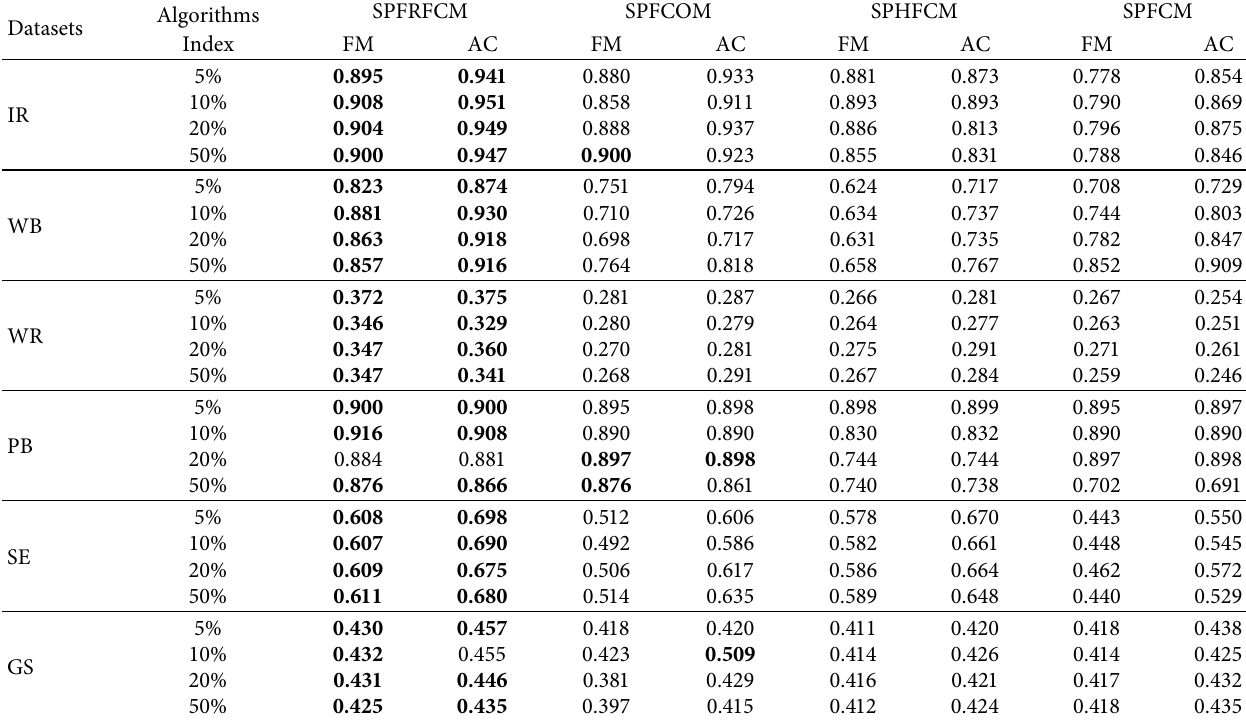
Table 2: Accuracy comparison of four single-pass